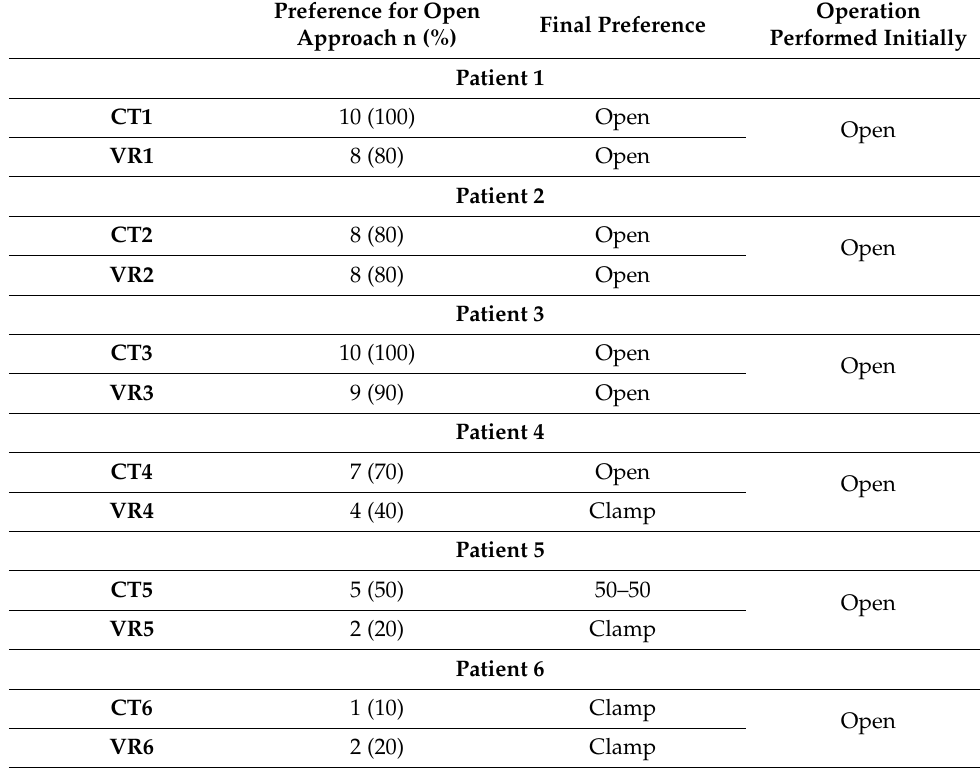
Table 1. Overall preference (n = 10) for clamped versus open distal ascending aortic anastomosis per patient based on computed tomography or virtual